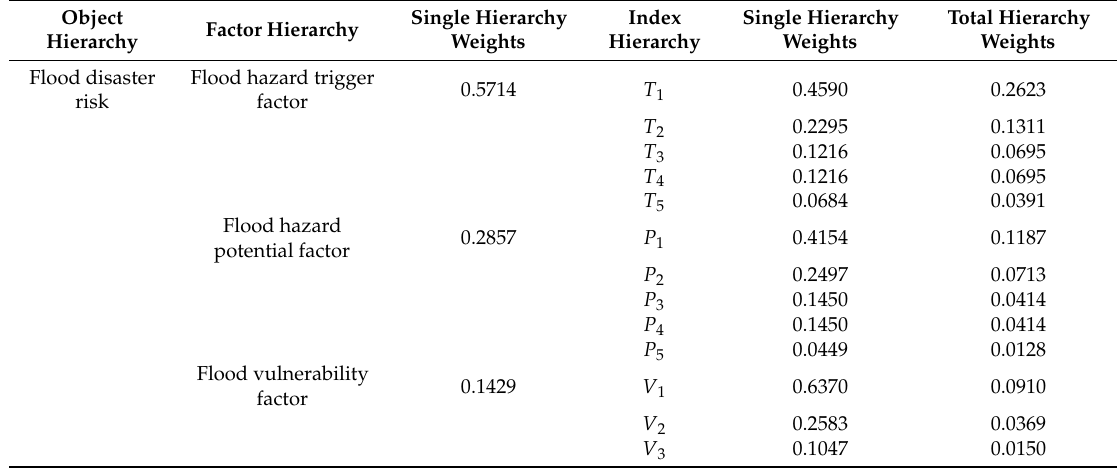
Table 4. Calibrated by